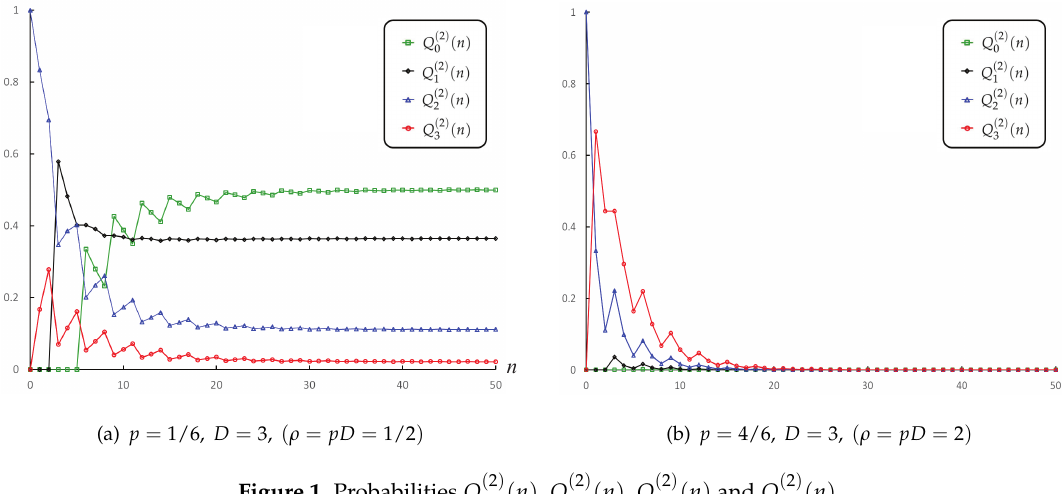
Figure 1. Probabilities Q